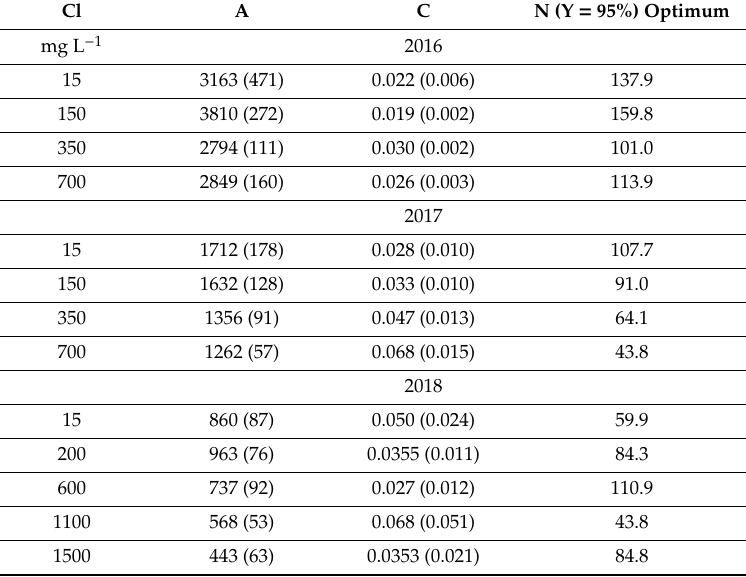
Table 5. Best fit parameters of the Mitcherlich equation for best fit curves of Potato tubers fresh weight as a function of N concentration in the irrigating solution at different Cl concentrations in the irrigating solutions (Figure 2). Numbers in brackets are the standard errors of the estimated parameters. The values of the parameters and their standard errors were determined using the Nlin procedure of JMP